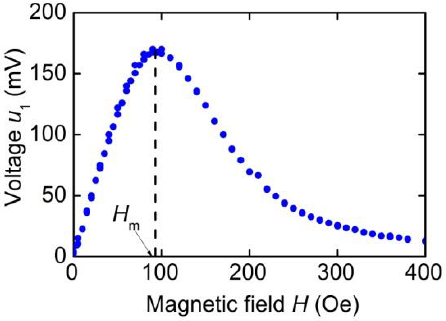
Figure 24. Dependence of ME voltage u on the field H for a monolithic Cu/NZFO/Cu-PZT heterostructure with integrated excitation system at a frequency f 1 .